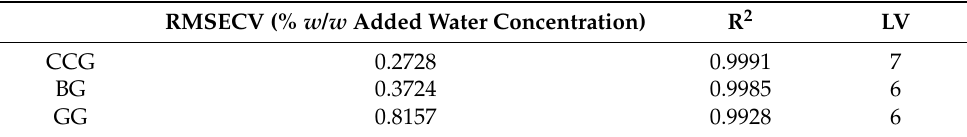
Figure 5. PLS regression models obtained from training sets using preprocessed spectra in the range 300–3750 cm − 1 for CCG ( A ), BG ( B ) and GG ( C ). Table 2. Summary of RMSECV obtained from PLSR applied on training SETs (SET_01 and SET_02).